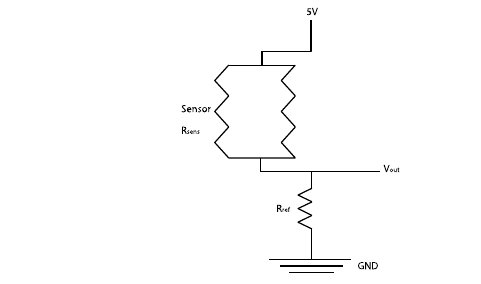
Figure 6. Voltage divider circuit.